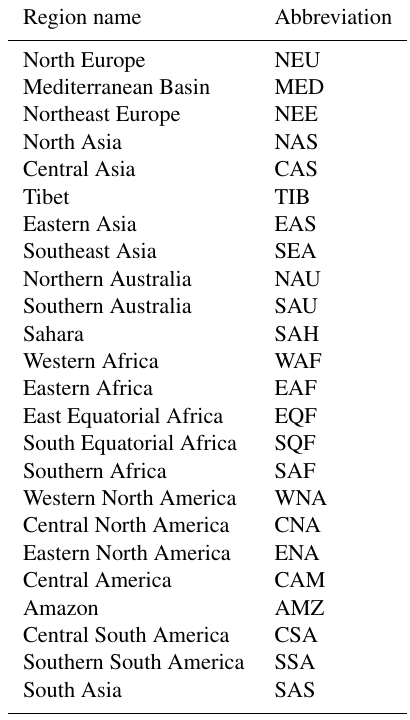
Table 2. 24 regions of the globe, selected from Giorgi and Bi